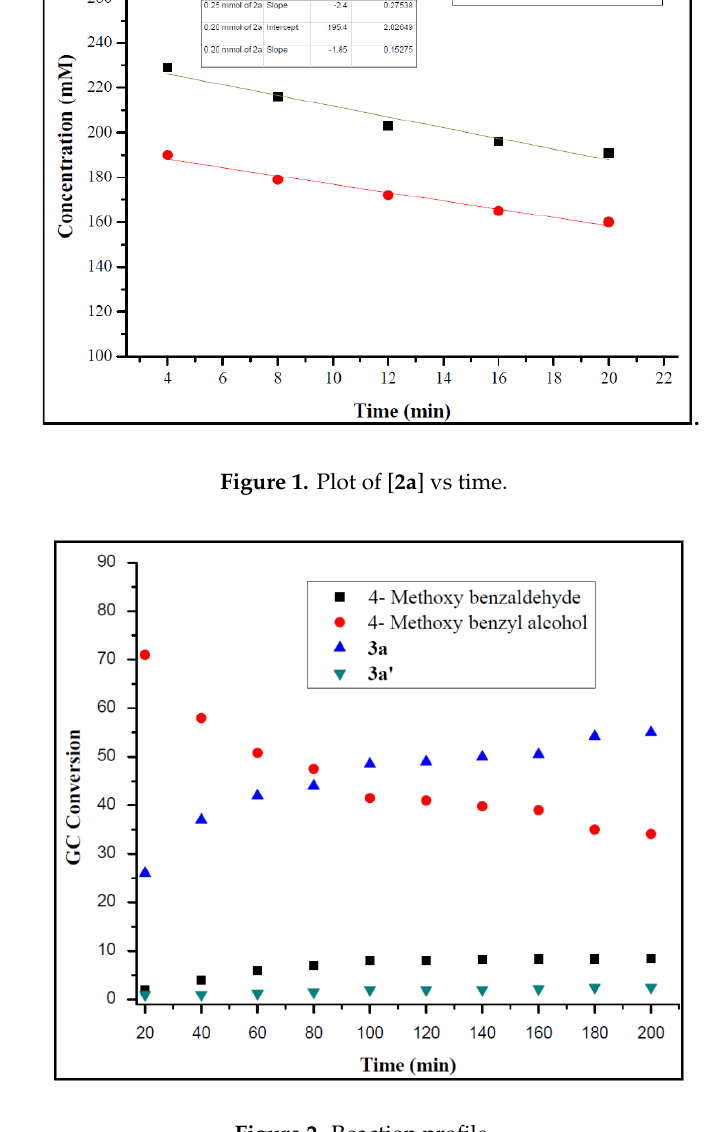
Figure 2. Reaction profile. Figure 2. Reaction